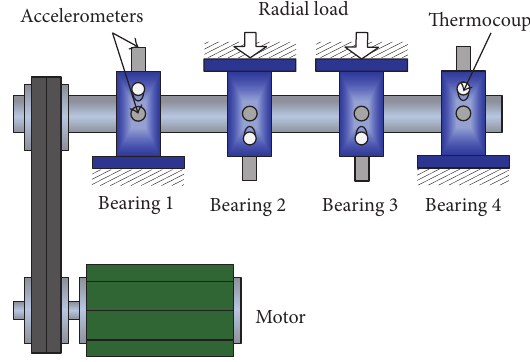
Figure 6: Bearing run-to-failure test